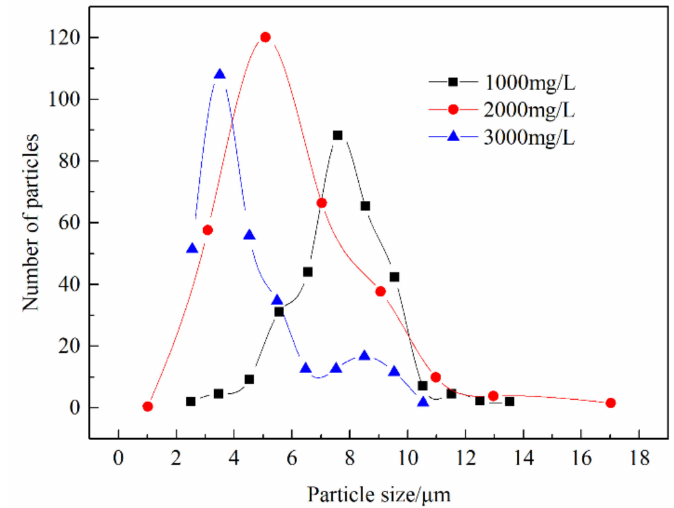
Figure 9. Relationship between the emulsion size distribution and the surfactant